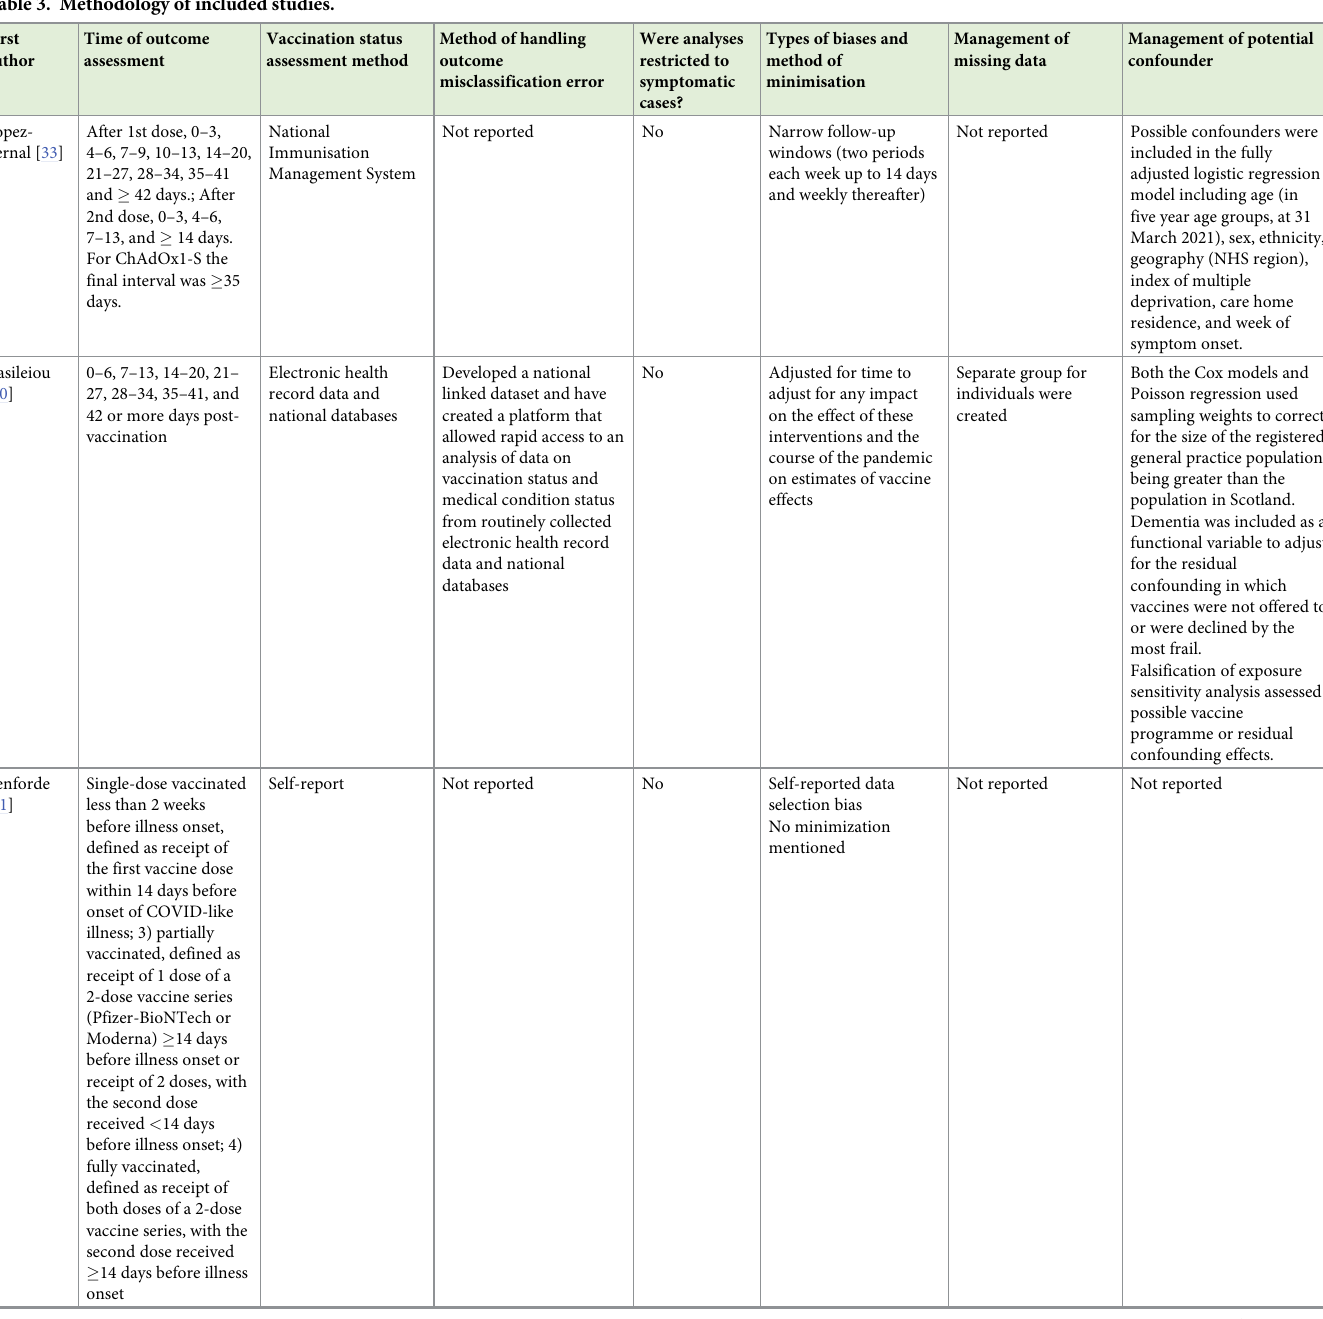
Table 3. Methodology of included